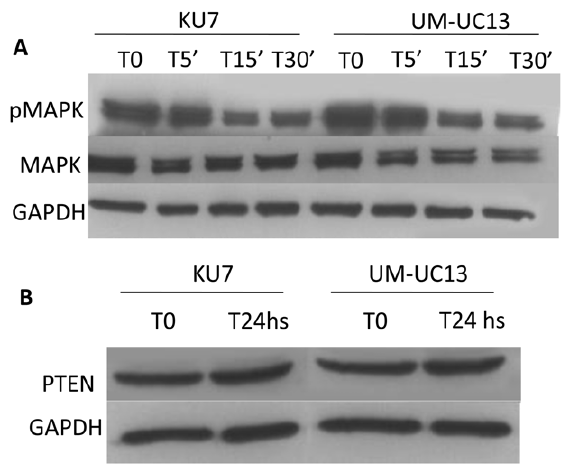
Figure 3. Effect of combination therapy on EGFR downstream signaling. (A) Phosphorylation pattern of p42/44 MAPK (Erk1/2) in cells treated with gefitinib 5 m M and DIM-C 3 m M for 5, 15 and 30 minutes. T0 is the untreated control. Whole-cell lysates were immunoblotted with phosho-p42/44 MAPK and p42/44 MAP. GAPDH was used as loading control on the Western blotting. (B) Comparison of PTEN expression in cell lines treated with gefitinib 5 m M and DIM-C 3 m M for 24 hs. T0 is the untreated control.